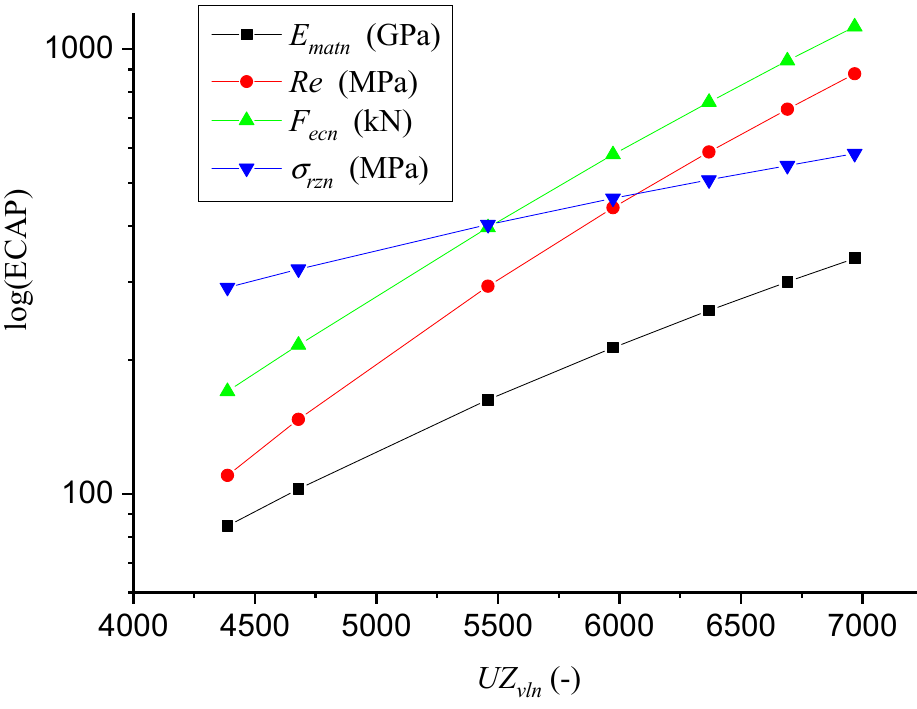
Figure 11. Correlation relations log f(ECAP) = f( UZ vln ).